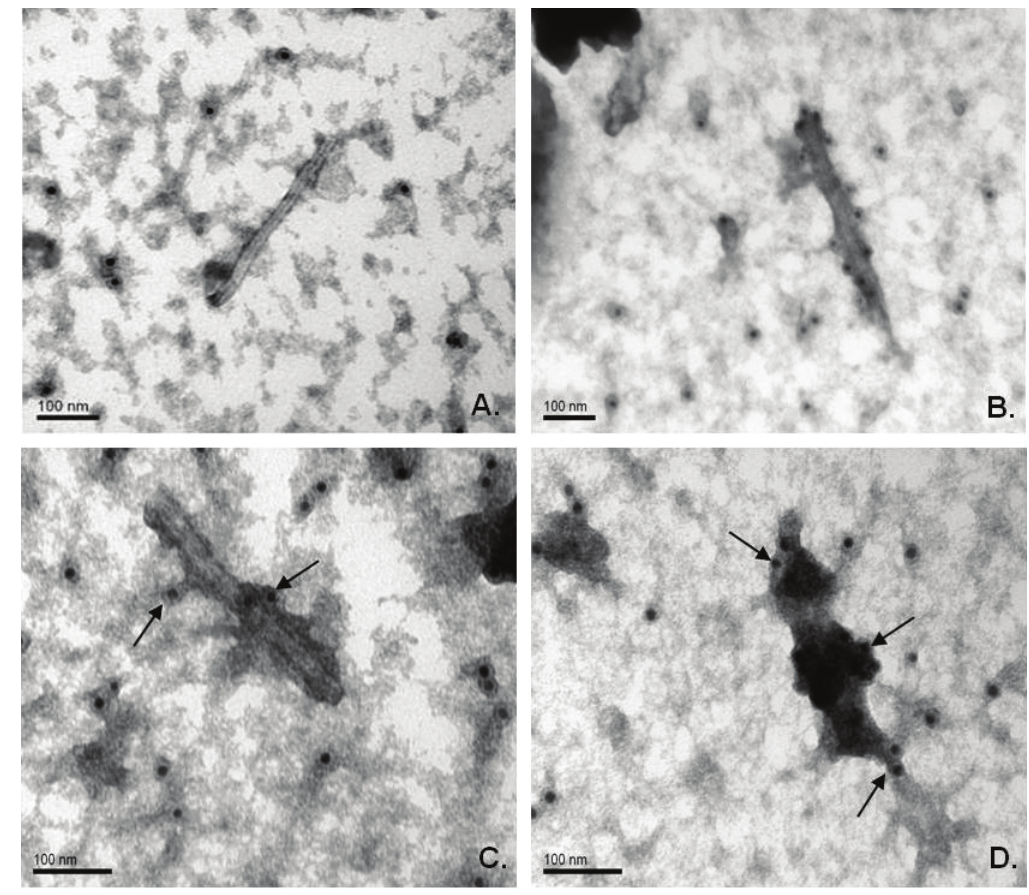
Figure 5. Immunogold labeling of chimeric viral particles in crude plant extracts. ( A ) TMV-wt-agro (wild-type); ( B , C ) TMV-M2e-cys; ( D ) TMV-M2e-ser. Primary antibodies, against DHFR-M2e; secondary (anti-mouse) antibodies, conjugated with gold particles (12 nm). Magnifications: A , B : 200,000; C , D : 300,000. Scale bars are